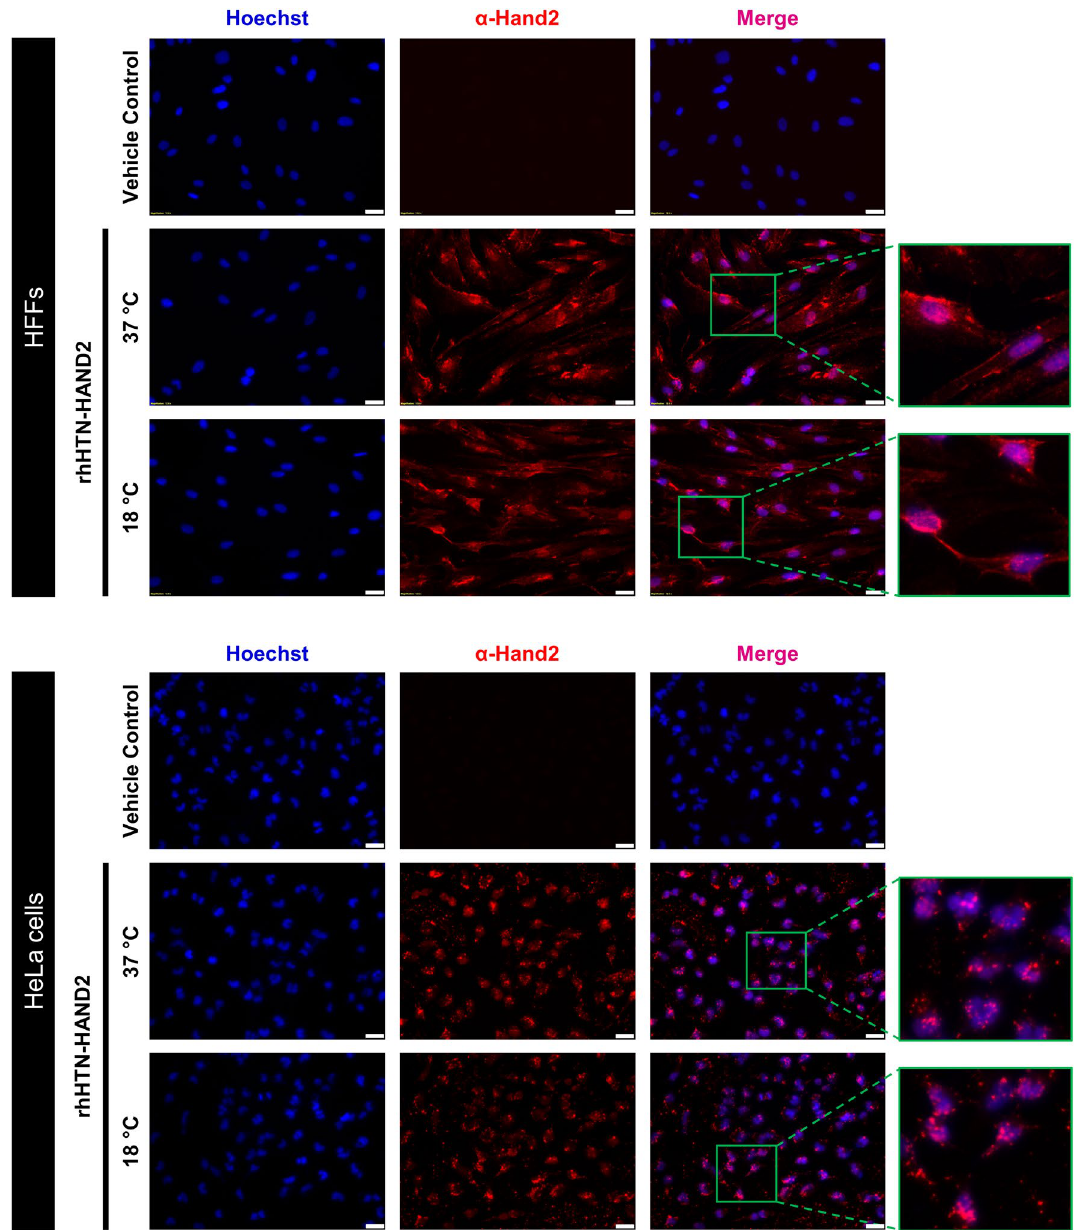
Figure 6. Subcellular and subnuclear delivery of purified rhHTN-HAND2 protein into human cells. HFF and HeLa cells were exposed to 200 nM of purified rhHTN-HAND2 protein for 4–6 h under standard cell culture conditions. After protein transduction, cells were fixed, permeabilized, blocked, and then stained with an α-Hand2 antibody. Transduced cells were detected with an Alexa Fluor® 594 conjugated α-rabbit secondary antibody. Nuclei were stained with Hoechst, and images were taken at ×20 magnification. All images were taken with identical camera settings. Scale bar: 50 μm (n =